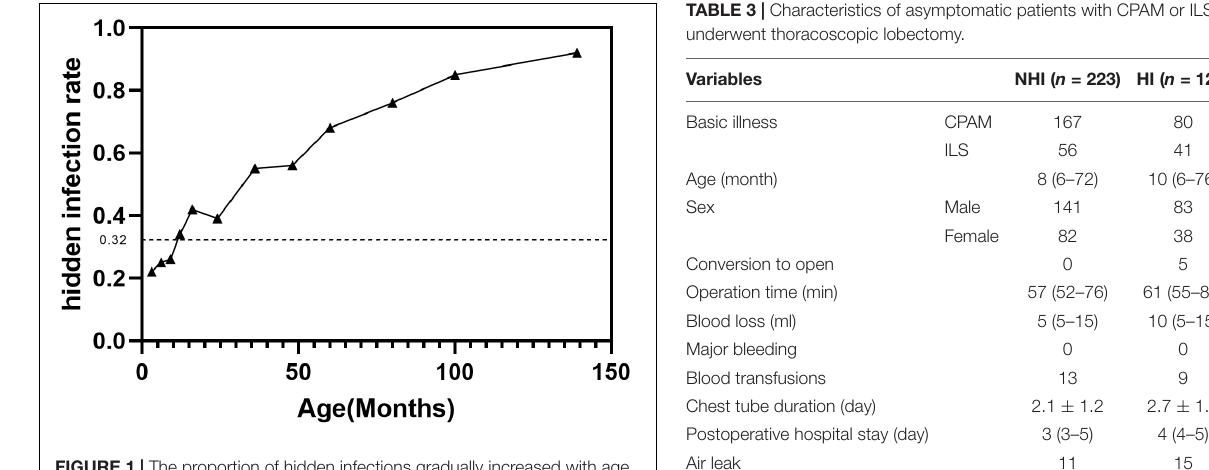
FIGURE 1 | The proportion of hidden infections gradually increased with age.